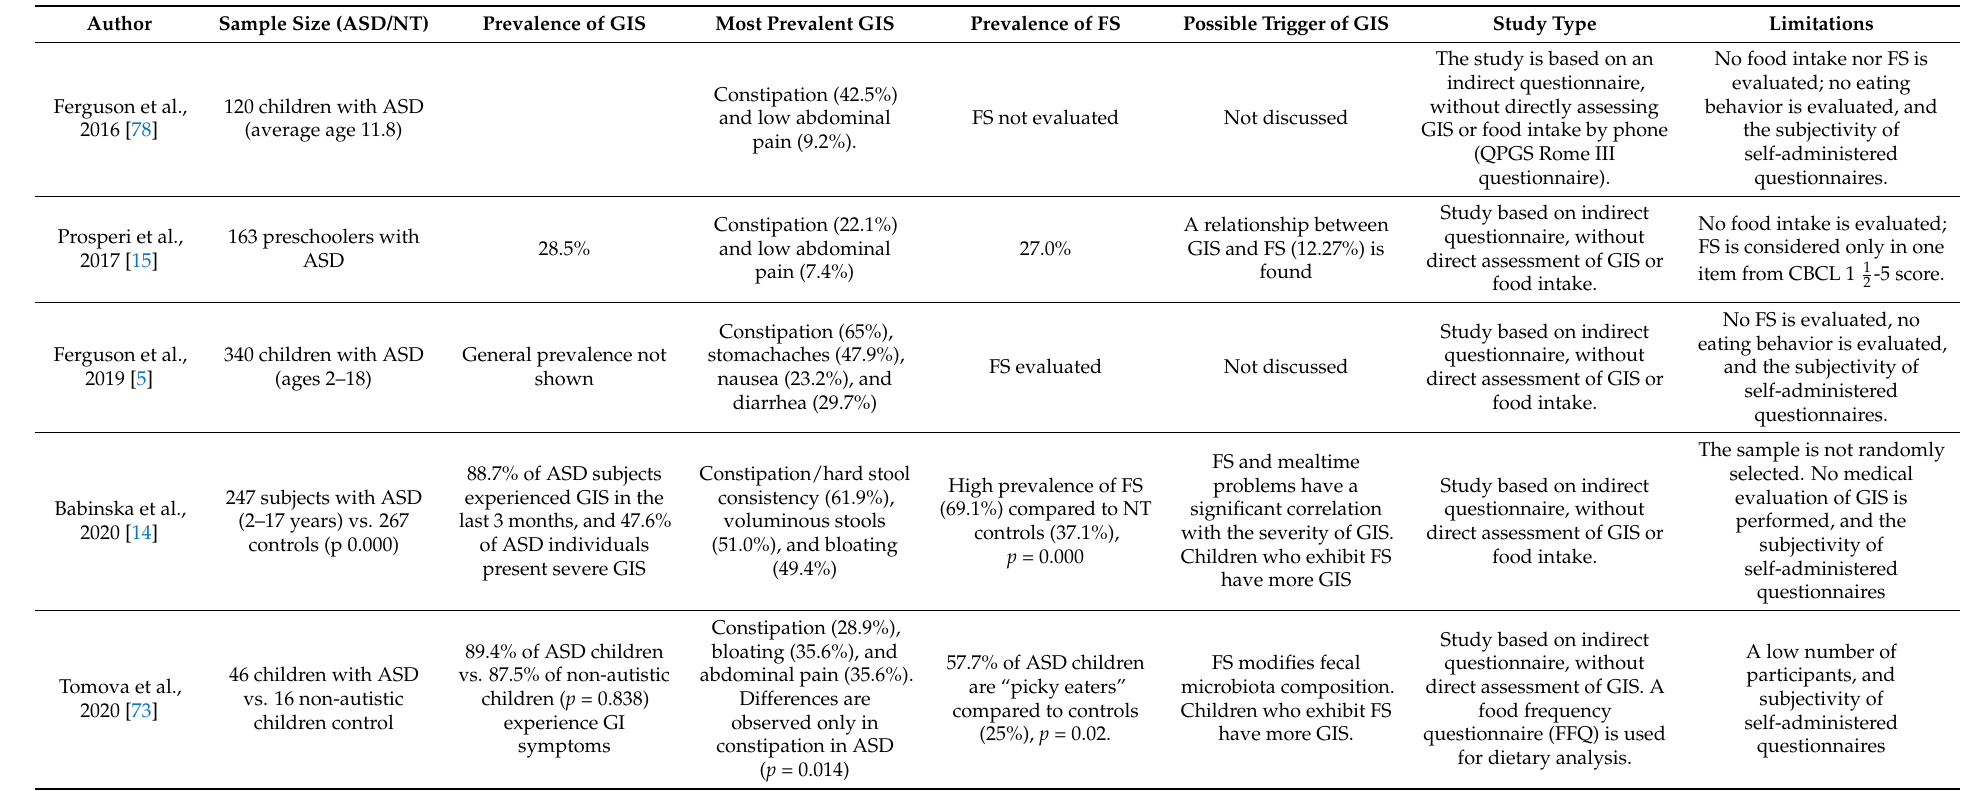
Table 3. Most prevalent gastrointestinal (GI) symptoms, food selectivity (FS), and possible triggers in subjects with autism spectrum disorder